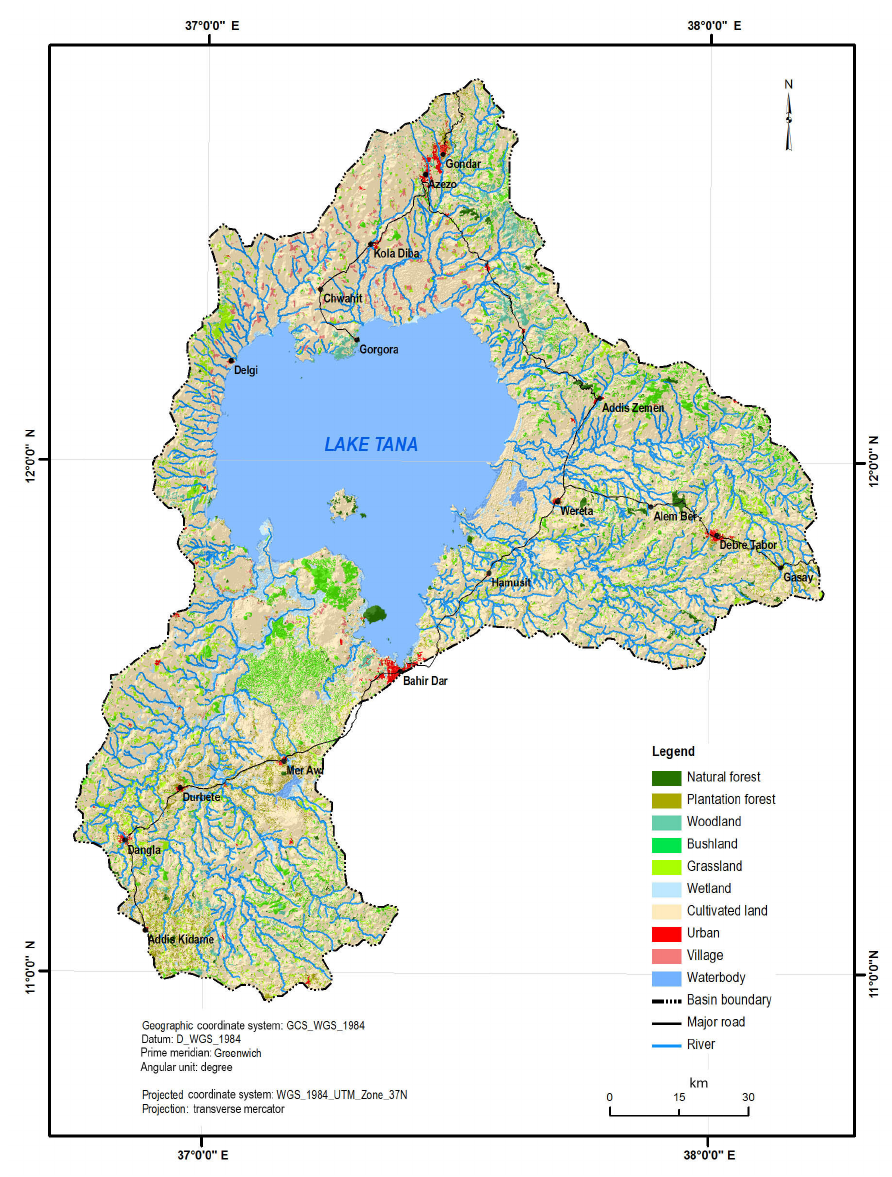
Figure 3. Vegetation map of the Lake Tana basin,